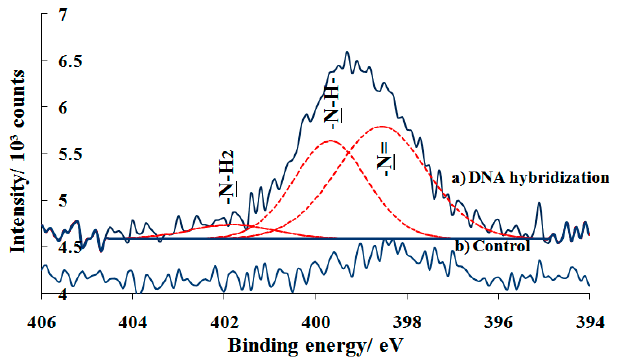
Figure 8. High resolution of N 1s XPS spectra for ( a ) DNA hybridization on UV modified sample and ( b ) control.